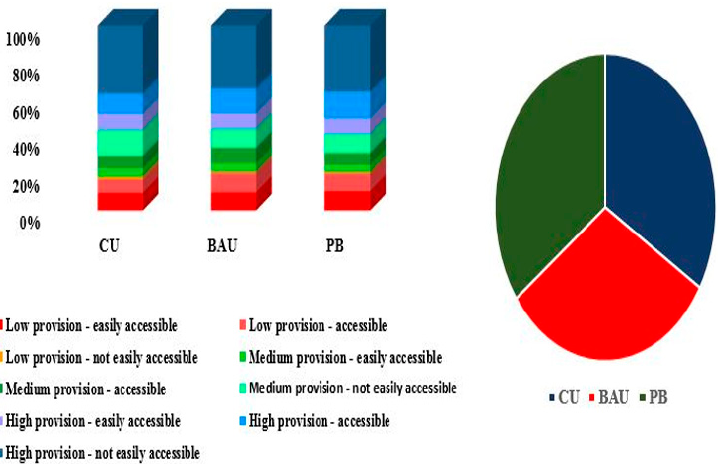
Figure 5. Percentage of land within each ROS category and the indicator value of outdoor recreational opportunity index in the Karaj landscape.